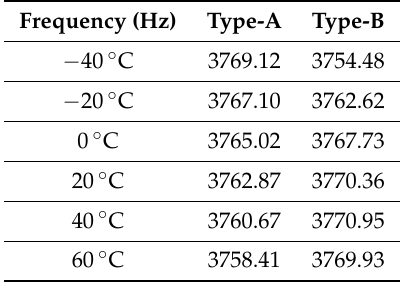
Table 5. The frequencies of the two structures at different temperatures ( f d